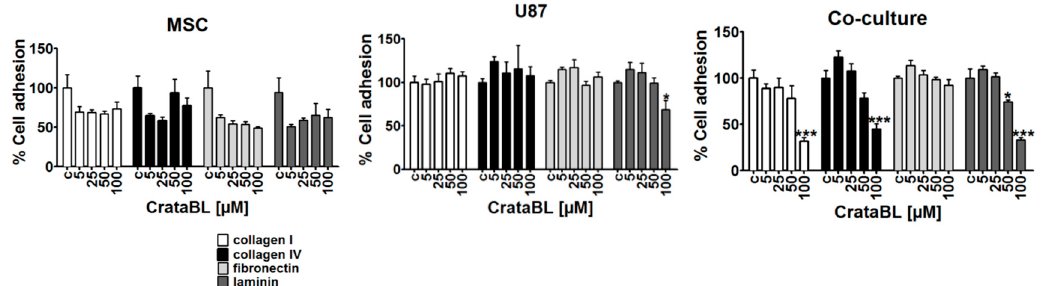
Figure 4. The effects of CrataBL on cell adhesion. Cell adhesion to collagen I, collagen IV, laminin, and fibronectin coatings was evaluated, as described in Methods on MSC, U87 glioblastoma cells, and cocultured cells at 5 µM, 25 µM, 50 µM, and 100 µM CrataBL concentrations, normalized to nontreated cells as control (c). Significance was considered at * p < 0.05, ** p < 0.005, and *** p < 0.0005.